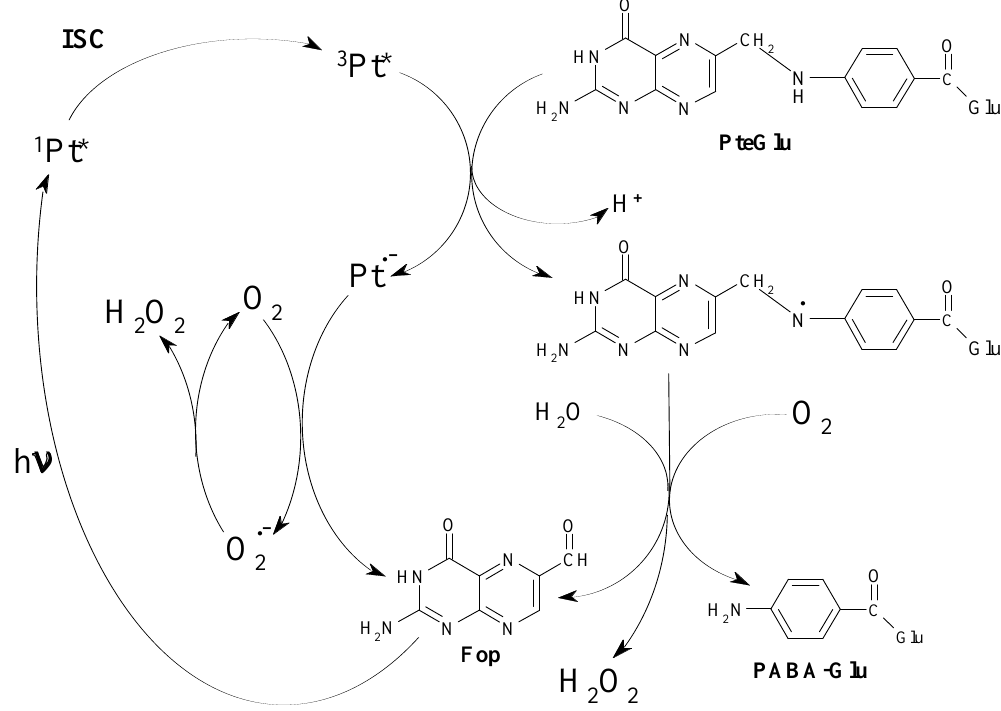
Figure 5. Mechanism of the photooxidation of folic acid (PteGlu).